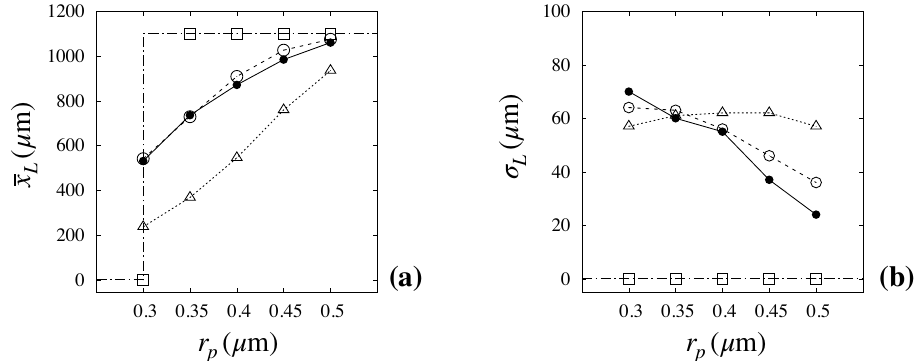
Figure 11. Comparison between predicted and measured values of the mean exit position, x l ( a ), and of the distribution variance σ L ( b ) vs. particle size. The experimental values (solid bullets) are taken from [6] Dash-dotted line with empty squares: kinematic model; Dotted line with empty triangles: advection–diffusion model with no ED effect. Broken line with empty circles: advection–diffusion model with ED